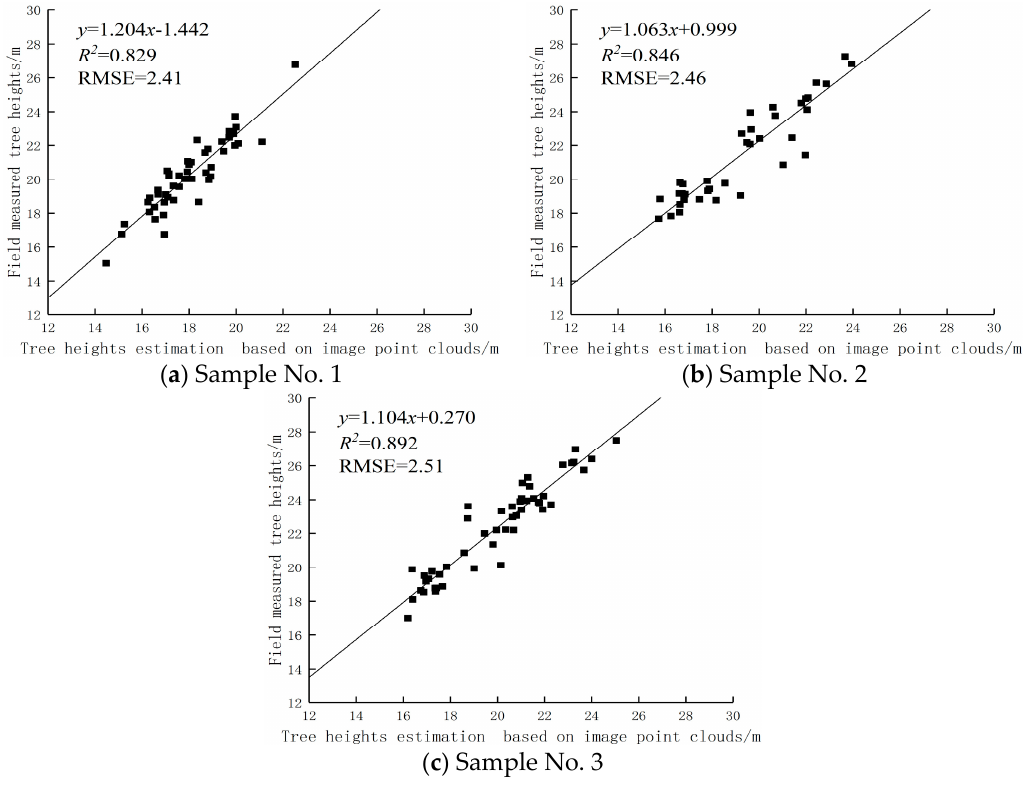
Figure 13. Comparative analysis of the tree height estimation values based on image point clouds and field measured values. ( a ), ( b ), and ( c ) are the height comparison analysis of plots 1, 2, and 3,